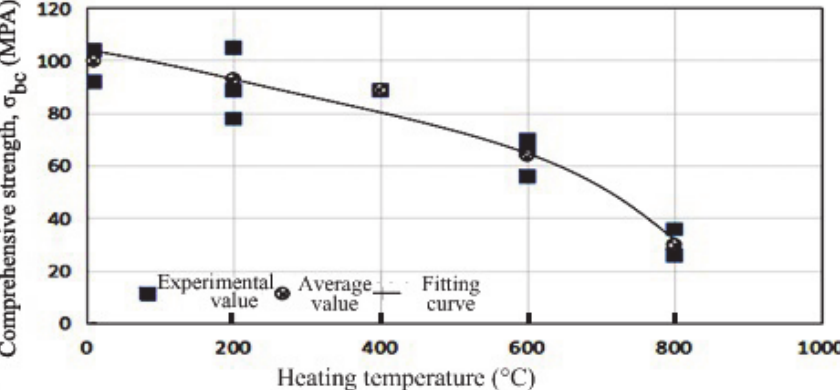
Figure 7: Relationship between compressive strength and heating